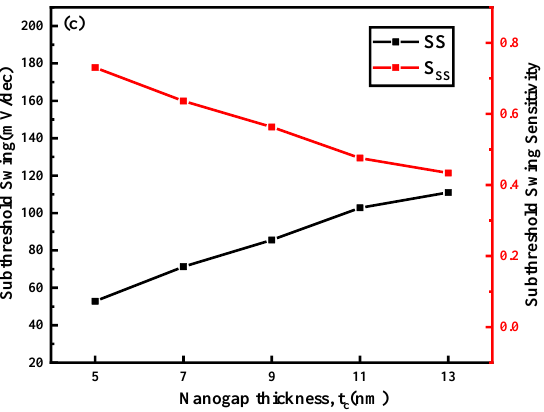
Figure 5. ( a ) Transfer characteristics and ( b ) S Vth and S d and ( c ) SS and S SS of the DM − SSTGTFET biosensor for different thicknesses of nanogap at V d = 0.5 V, V g = 1 V and k = 14. Figure 6 shows a cross-section of a part of the source region and the drain region near the left side of the gate. This figure shows the hole generation and electron generation for band – band tunneling at different nanogap thicknesses. As the thickness of the nanogap increases, the rate of hole and electron generation decreases. Therefore, the more difficult the biosensor is to turn on, the greater the threshold voltage and the greater the decrease in the on-state drain current. This is consistent with the conclusion drawn in Figure 5b.